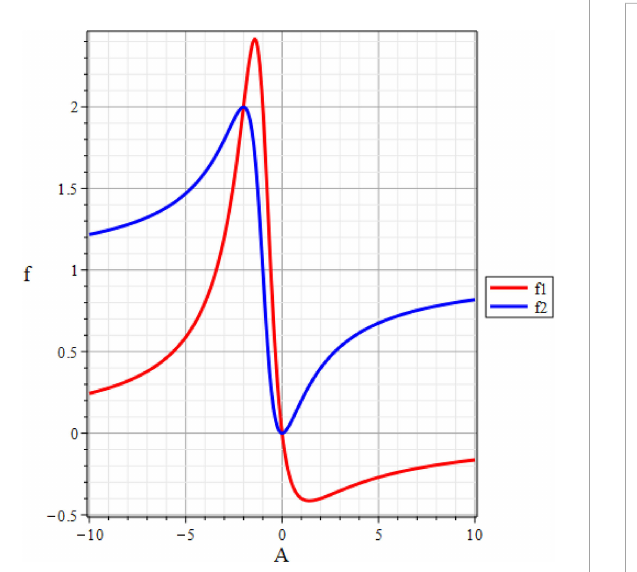
FIGURE 4 Attenuation rate Q as a function of nondimensional imaginary Robin parameter B for various values of nondimensional real Robin parameter A